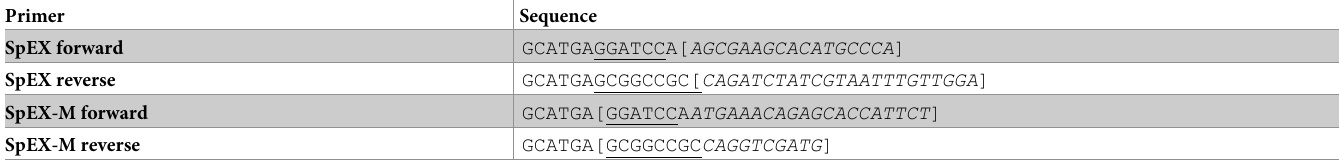
Table 2. Primers used to amplify recombinant wild- type and attenuated spEX from Staphylococcus pseudintermedius and pUC19- spEX- M plasmid. NotI and BamHI restriction sites are bold and underlined, nucleotide sequences belonging to SpEX and SpEX-M are show in italics, the primer binding sites are in brackets and sequences outside SpEX and SpEX-M (GCATGA) were used to flank NotI and BamHI recognition sites.